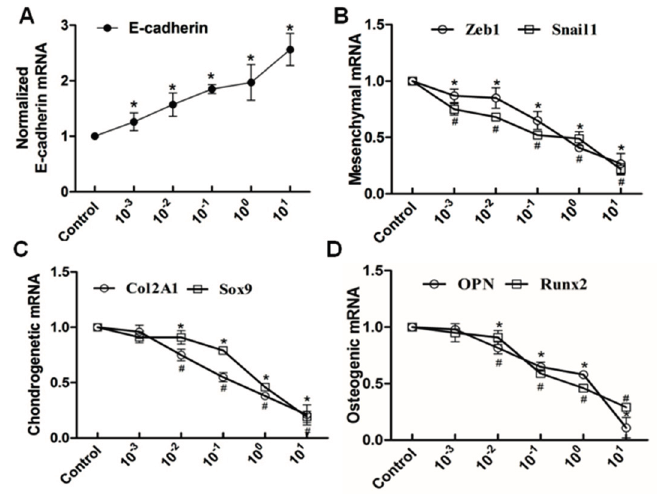
Figure 6. RT-PCR analysis showed that the elevated level of nifedipine attenuated EMT and potential osteochondral differentiation in PRECs. Cells were treated with the indicated concentration of nifedipine for 24 h; RT-PCR was used to examine the expression diversities of epithelial, mesenchymal and osteochondral markers. Data showed the increased expression of E-cadherin ( A ); and decreased expression of Zeb1 and Snail1 ( B ); Col2A1 and Sox9 ( C ) and OPN and Runx2 ( D ) with increasing amounts of nifedipine. * p < 0.05 vs. the control (without nifedipine) for E-cadherin, Zeb1, Sox9 and Runx2. # p < 0.05 vs . the control (without nifedipine) for Snail1, Col2A1 and OPN.